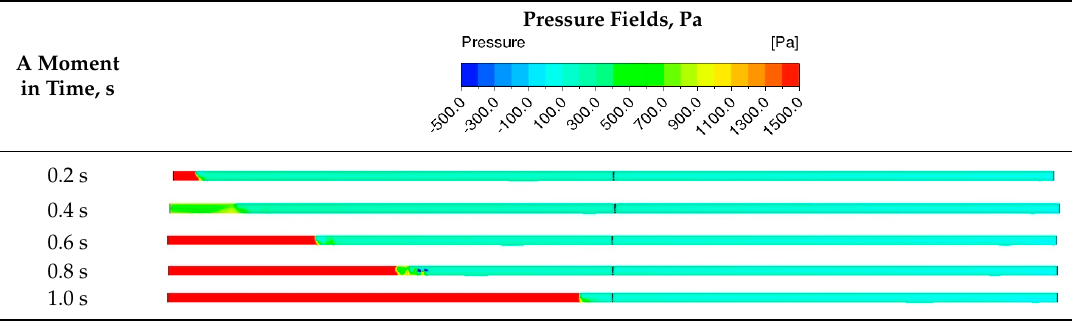
Table 6. Pressure fields over time in a system with mesh partitions.